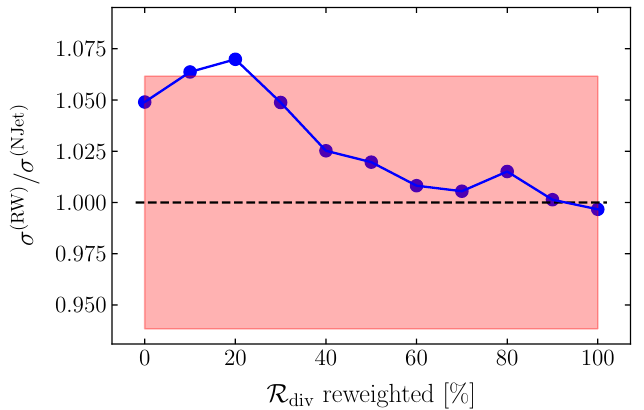
Figure 9. Effect of reweighting points in the divergent region of phase space, R div , on the ratio between the reweighted cross section, σ (RW) , and the cross section calculated using NJet σ ( NJet ) for the 2 → 4 process. In this case, the divergent region comprises approximately 2–3% of the total phase space (see appendix B for details). The red band shows the MC error on the NJet result.